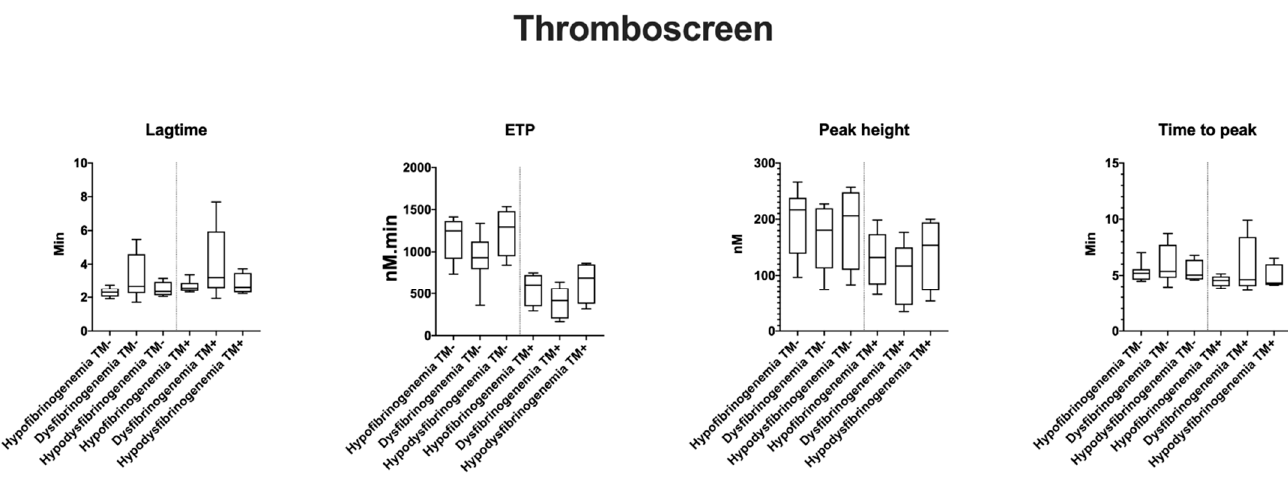
Figure 3. Mean TG variables with STG-TS (thromboscreen) according to laboratory phenotype and the supplementation of TM. TG values are shown for 19 patients as follows: asymptomatic n = 13; bleeding n = 4, thrombosis n = 2; hypofibrinogenemia n = 8; dysfibrinogenemia n = 8; and hypodysfibrinogenemia n =3.